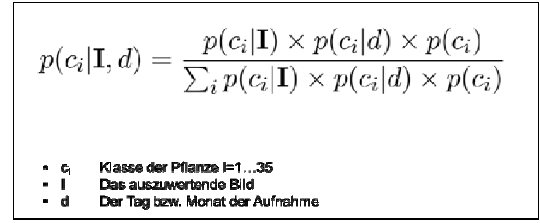
Figure 5: Flower recognition probabilities parts (i) to (iii) with c i class of the plant (at the beginning 35) classes, the image I and the day of acquisition d (Source: Oswald Figure 2: Flower recognition elements with smartphone (Source: Boris Willi).